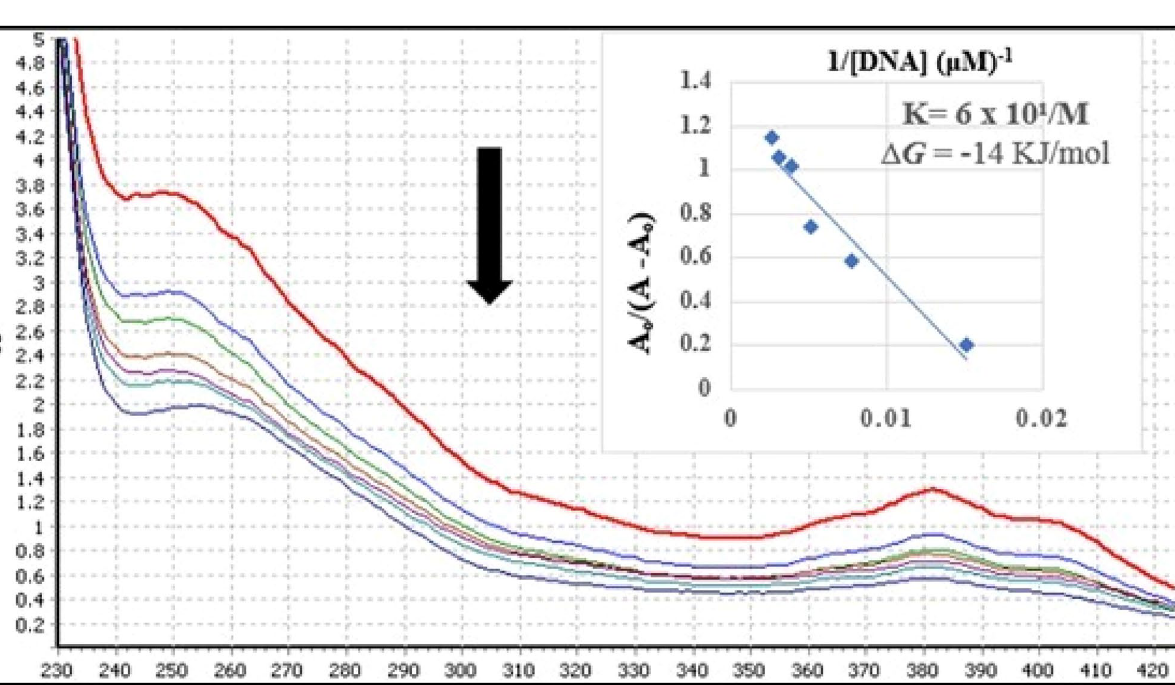
Figure 3. Compound 5j induced cell cycle arrest. ( A ) The representative results of cell cycle analysis obtained by flow cytometry in untreated (control) and compound 5j treated cells. ( B ) The proportions of G0/G1, S and G2/M phases are represented as mean ± SD. * p ˂ 0.05, ** p ˂ 0.01, *** p ˂ 0.001 versus control group (n = 3).